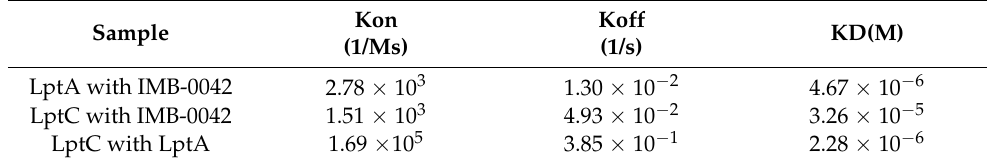
Figure 4. SPR analysis for the binding of compound IMB-0042 with LptA and LptC proteins and the effect of IMB-0042 on LptA/LptC interaction. ( A , B ) The binding of compound IMB-0042 to LptA or LptC protein. Serially concentrated solutions of IMB-0042 (from 2.0 µg/mL to 16 µg/mL) were injected into the chamber with a Carboxymethyl Dextran sensor chip coated with LptA ( A ) or LptC. ( B ) The change of response units is shown. ( C ) Demonstration of LptA/LptC interaction. LptC was immobilized on the SAM sensor chip, while LptA, with concentrations ranging from 0.164 µM to 2.624 µM, was passed through the chip. The change in response units is shown. ( D ) Compound IMB-0042 blocked LptA/LptC interaction. LptA proteins preincubated with or without compound IMB-0042 were injected into a chamber with an LptC-coated SAM sensor chip. The change of response units was measured over time. Table 1. The kinetics evaluation of the SPR